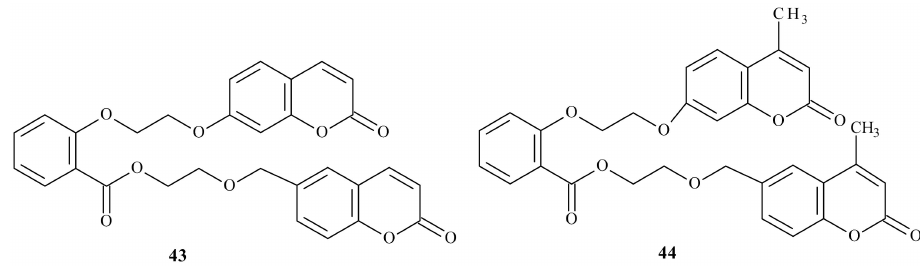
Figure 15. Structure of anticoagulants 43 and 44 .